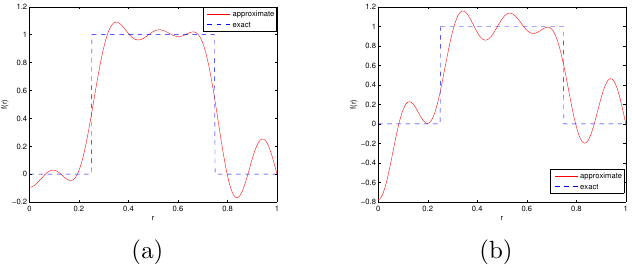
Figure 3. Example 2. Method 1 with different noisy levels: (a) result by M1 with δ = 0 . 01, (b) result by M1 with δ = 0 . 03.